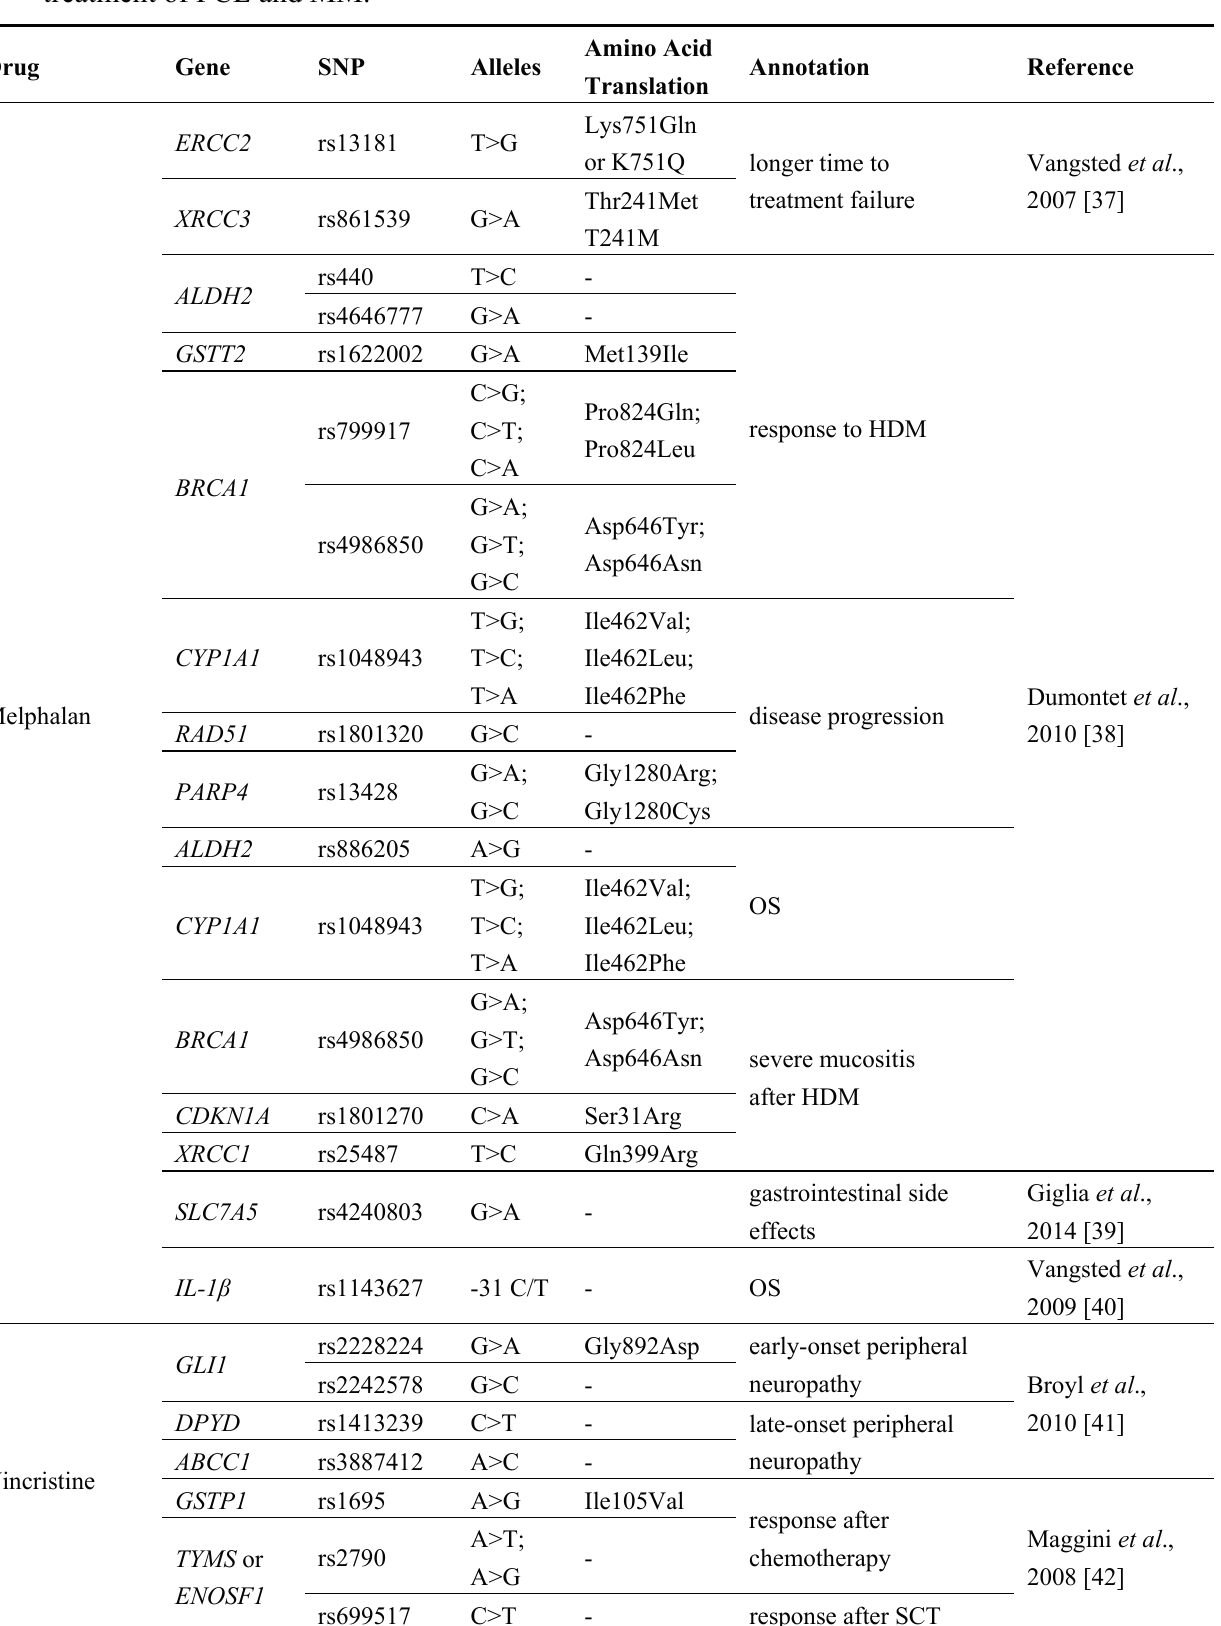
Table 2. Germline genetic variations and efficacy/safety of old and new drugs used in the treatment of PCL and